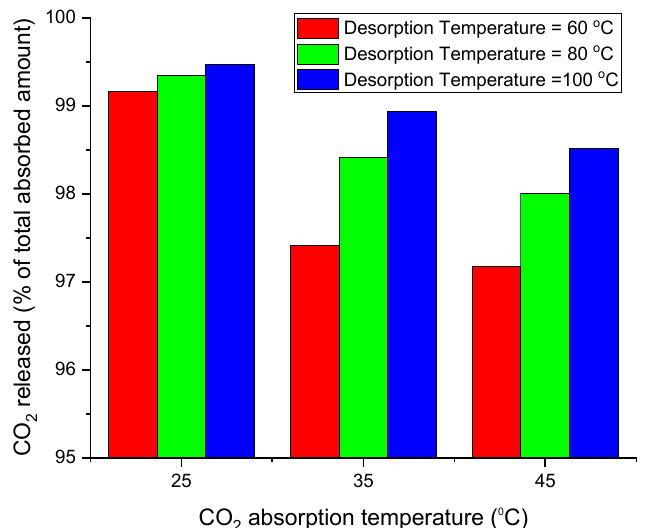
Figure 14. The total CO 2 released from ChCl:LvAc (1:3:0) samples that absorbed CO 2 at 25 °C, 35 °C and 45 °C and released CO 2 at 60 °C, 80 °C and 100 °C.